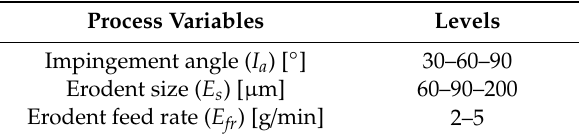
Table 4. Process variables’ levels used in the planned